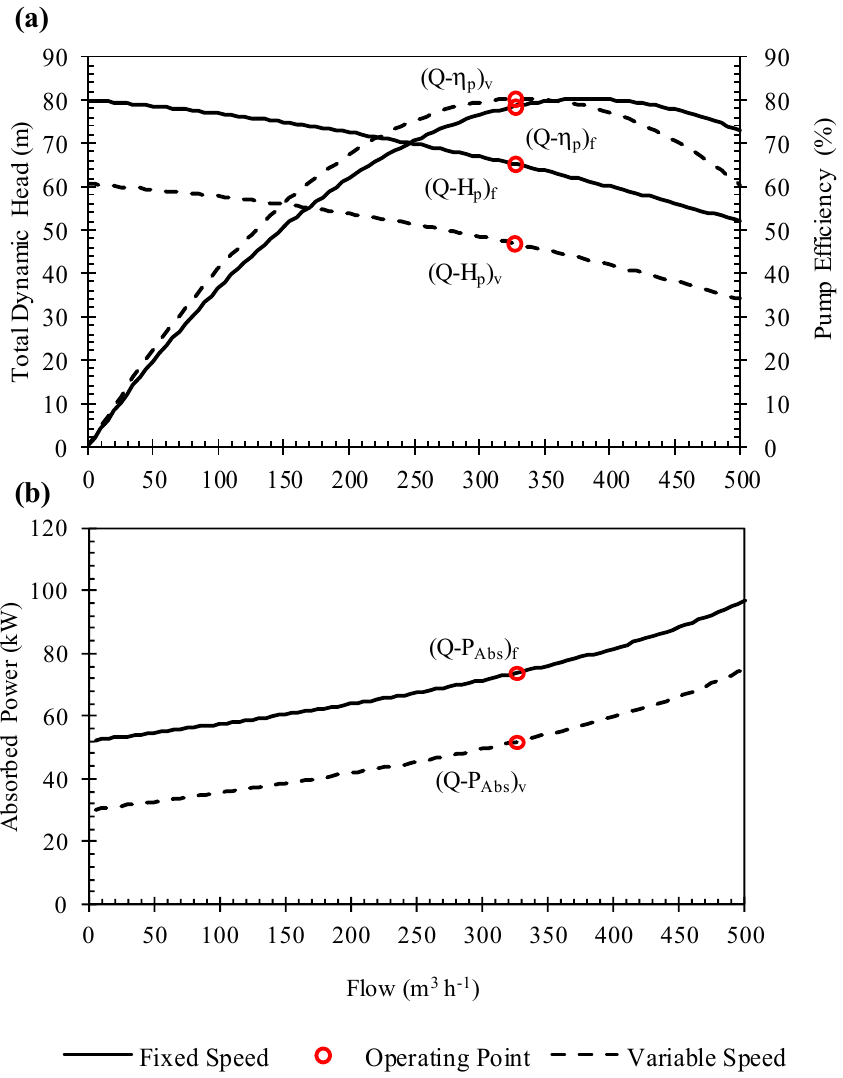
Figure 5. Pumping station characteristic curves for the 40° angular position lateral line with a fixed speed (f) and variable speed (v), ( a ) (Q-H) and (Q- η) curves, ( b ) (Q-P Abs ) curve.